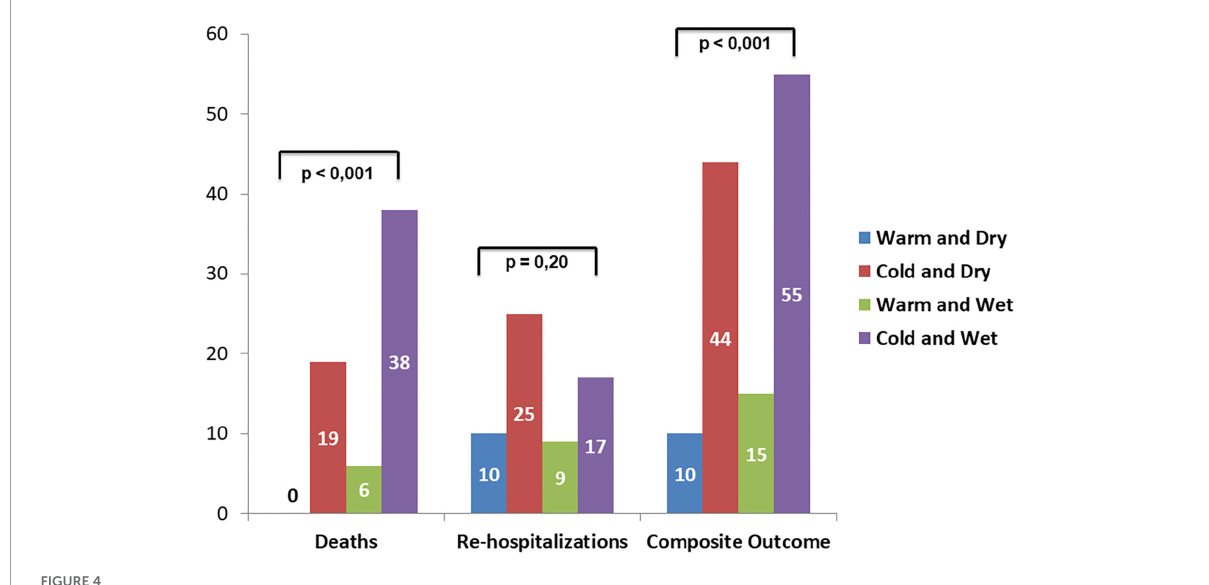
FIGURE4 Adverse events rate among AHF patients’ groups according to Stevenson presentation: left bars show death, middle bars refer to re-hospitalization, and right bars refer to the composite outcome.